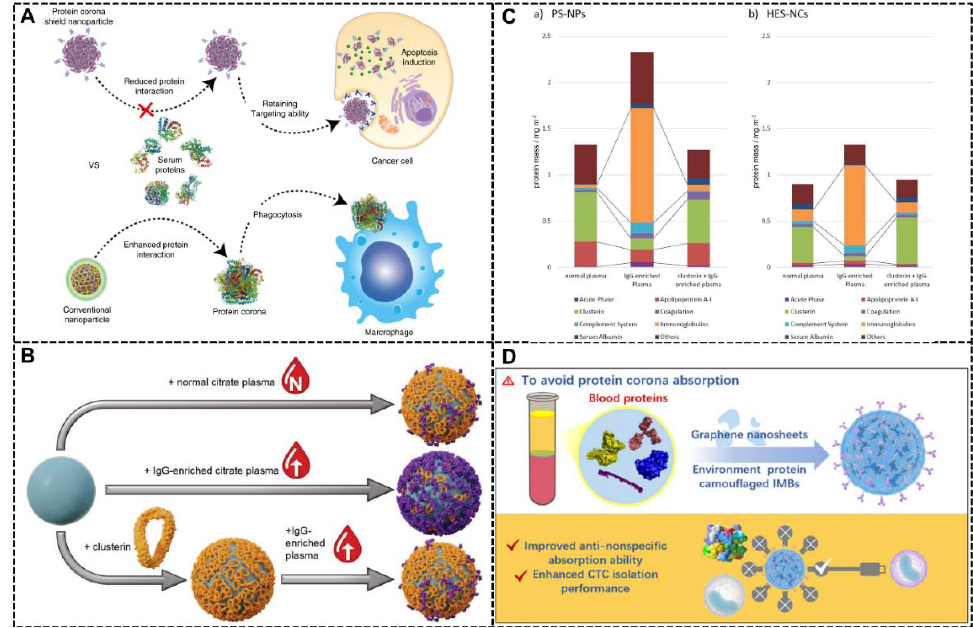
Figure 7. Endogenous protein coating for stealth effect. ( A ) The system with supramolecular precoating shows the effect of protein corona shield by reducing the interaction between the NPs and biological fluids and preventing the protein corona formation for retaining targeting ability [54].